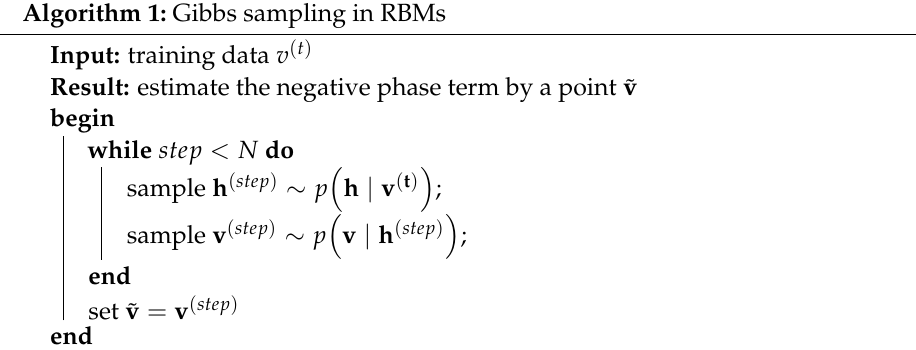
Algorithm 1: Gibbs sampling in RBMs